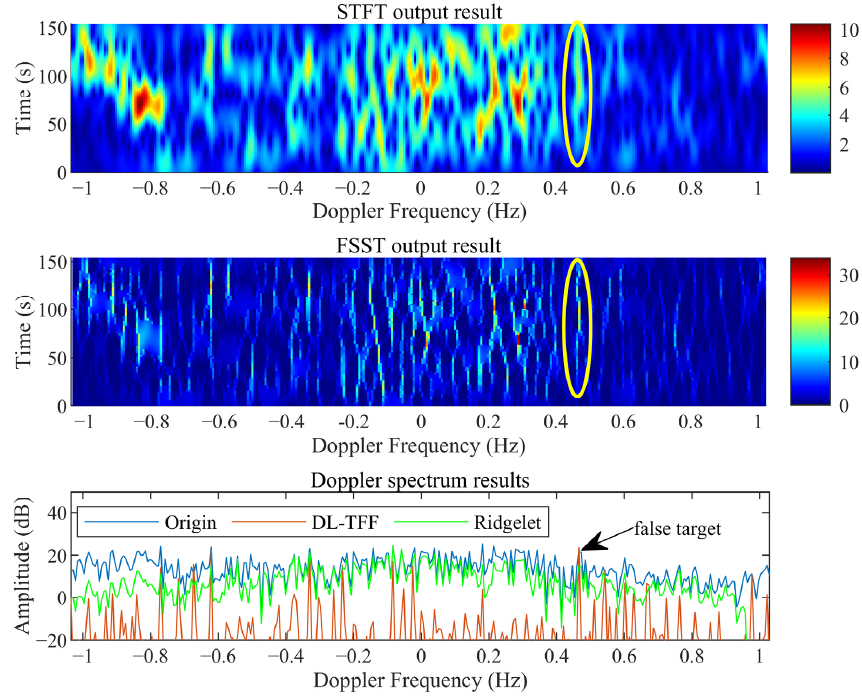
Figure 11. The local region experiment results of the corresponding transform and DL-TFF framework.